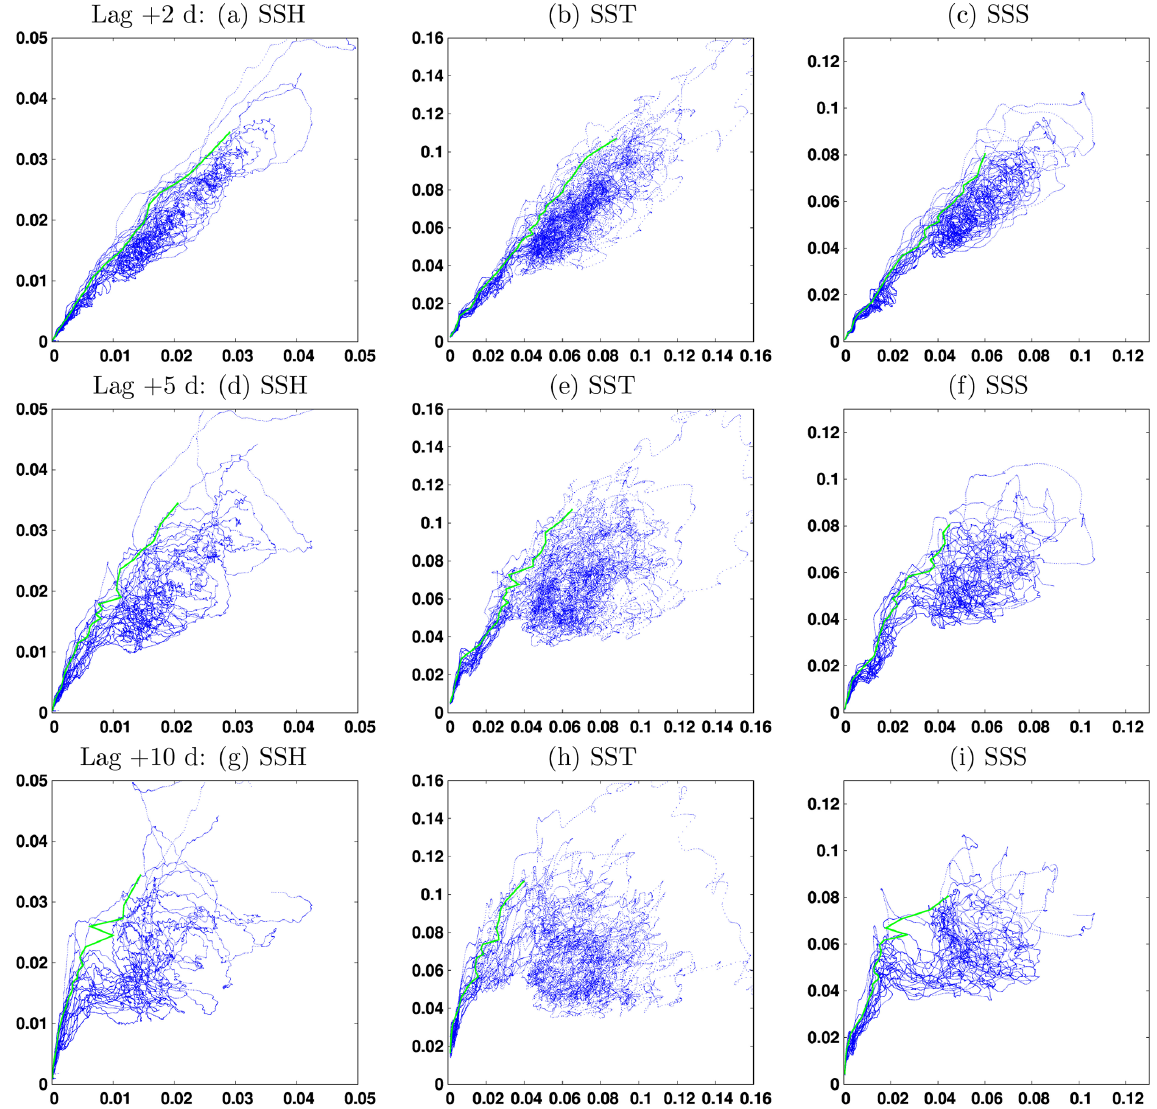
Figure 9. Final CRPS score ( y axis) as a function of the initial CRPS score ( x axis), for three time lags (cid:49)t = 2, 5, and 10d (from top to bottom) for SSH (meters), SST (degree Celsius) and SSS (psu). The green line corresponds to the initial score required to have a 95% probability that the final score is below a given